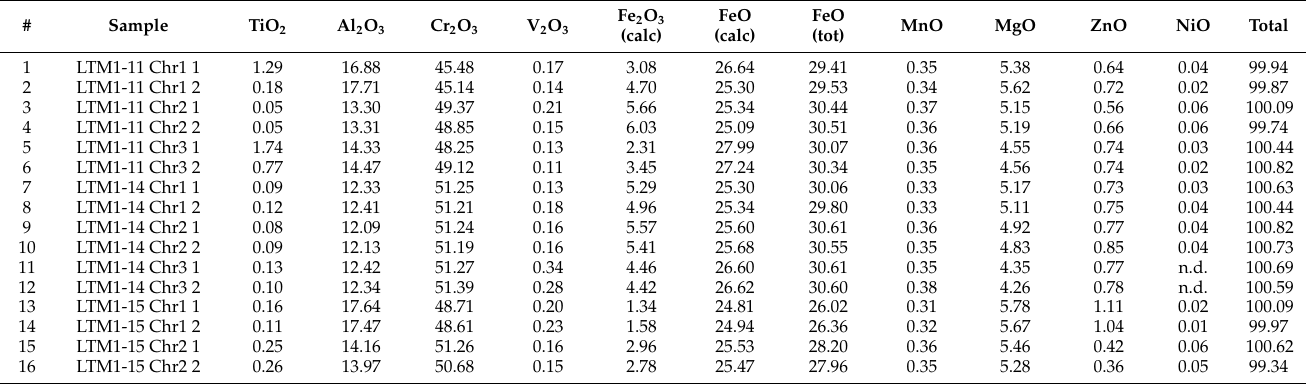
Table 4. Compositions of grains of chromian spinels in the orthopyroxenite zone of the Lotmvara-I sill, Kola